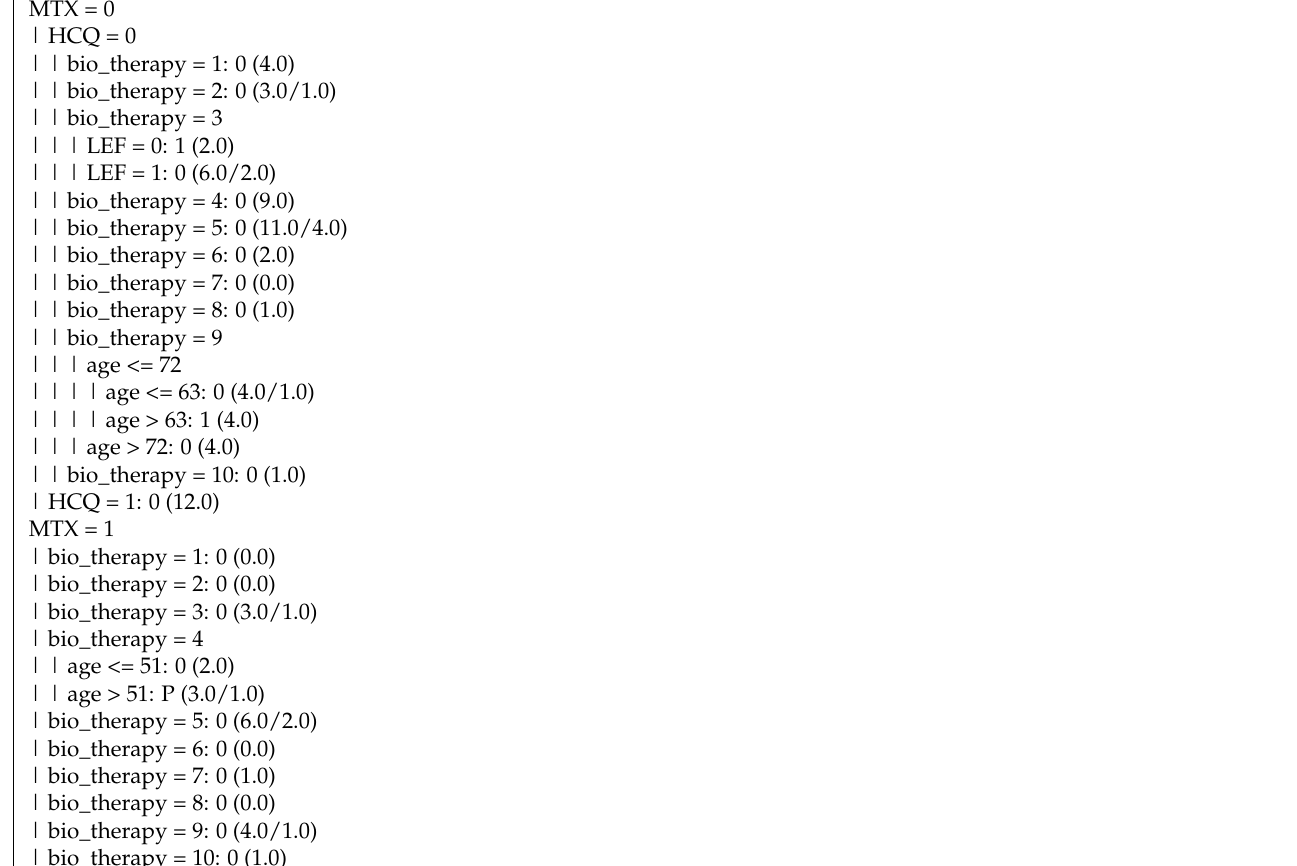
Table 12. Decision tree for the positivation of QuantiFERON-TB Gold Test, obtained with the C4.5